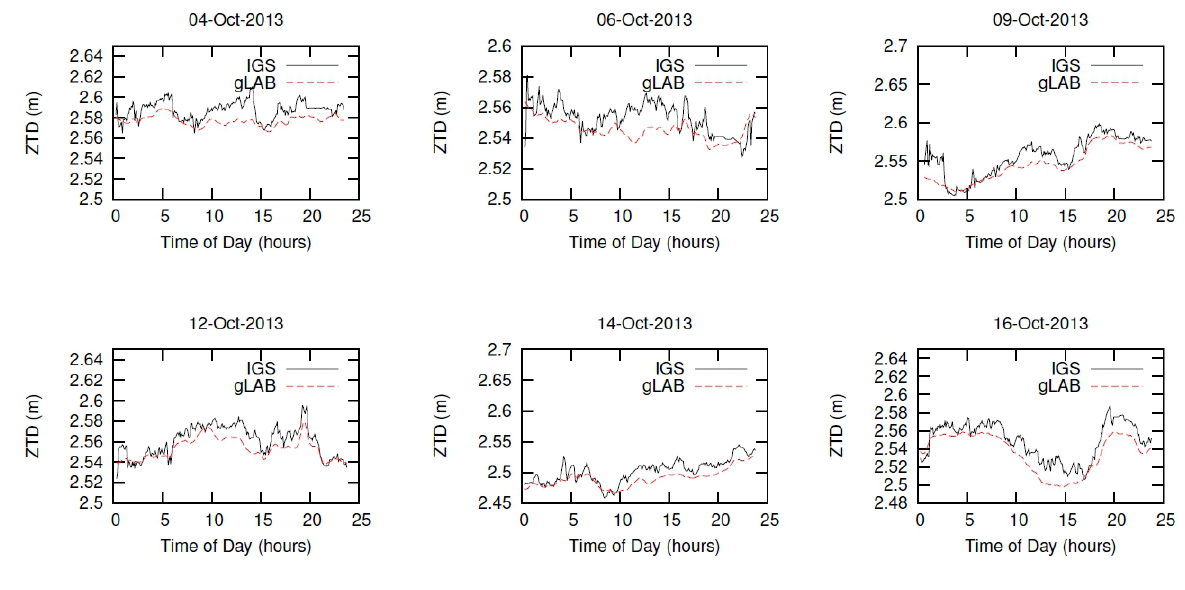
Figure 4: ZTD plot against Time-of-day for IGS server values and gLAB computations for Yamoussoukro, Cote d’Ivorie